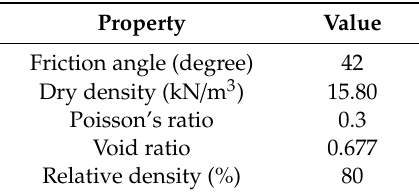
Table 2. Input properties of model soil.